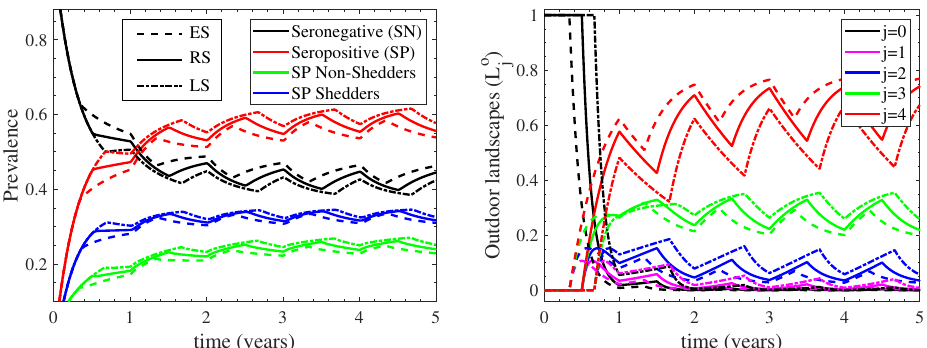
Figure 7. Comparison of the extended seasonal (ES) and limited seasonal (LS) housing cases with the regular seasonal (RS) case. The left panel depicts the prevalence of seronegative (SN) and seropositive (SP) cattle, accounting for non-shedders and shedders. The right panel shows the outdoor environmental load of the contaminated landscapes L o landscape L o 0